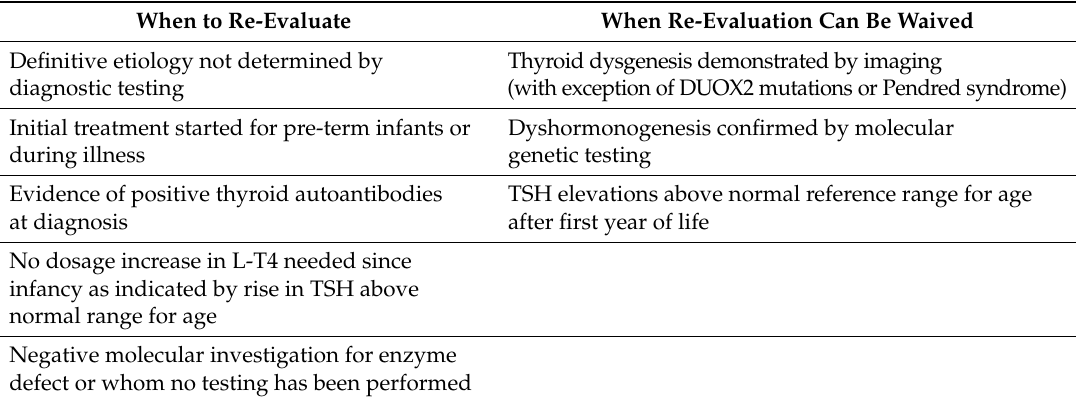
Table 6. Recommendations for re-evaluating the thyroid axis